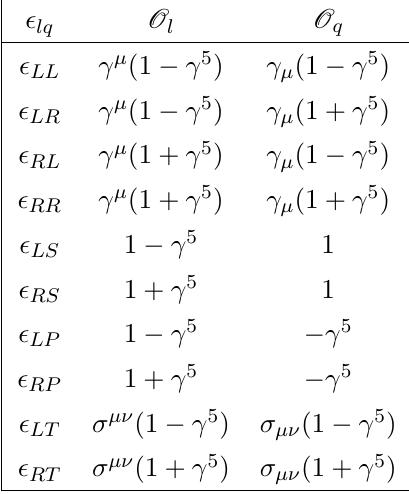
Table 2. Parameters and their corresponding Lorentz structures for the BSM currents considered in this